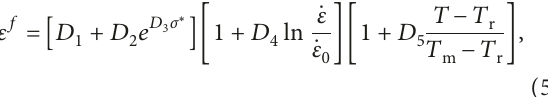
Figure 6: High-speed photographs of explosive bolt separation. (a) t � 6966 μ s. (b) t � 8186 μ Table 1: Material parameters of PETN. Parameters